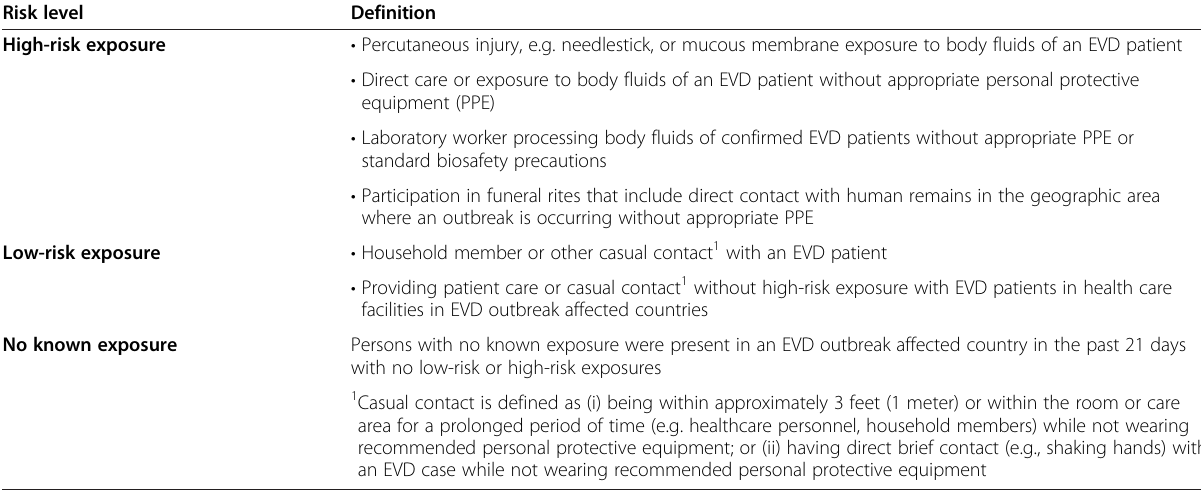
Table 3 Definition and assessment of risk exposure